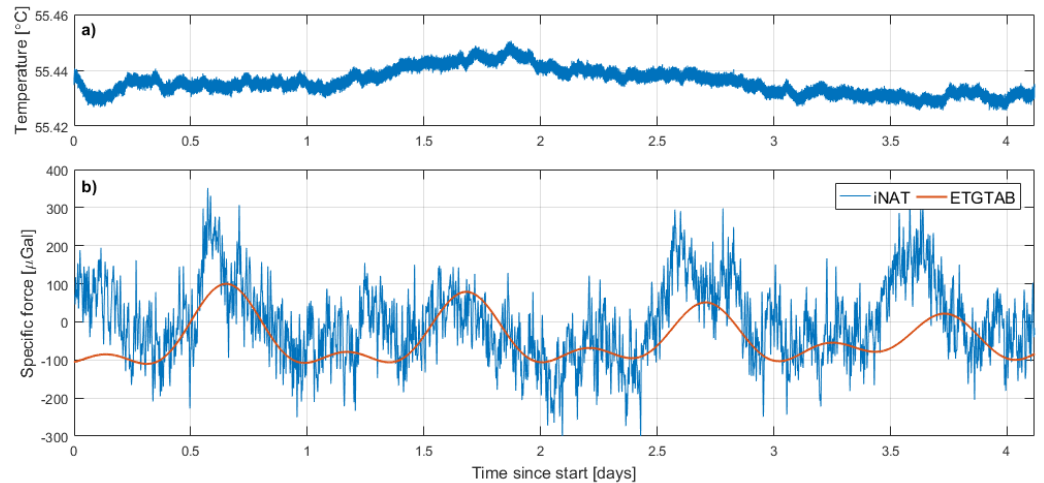
Figure 1. Observations from the four-day static recording: ( a ) Temperature log. ( b ) Accelerometer measurements filtered with a time constant of 300 s and corrected for a linear trend of − 869 µ Gal/day. Also shown are the modelled solid Earth tides using the ETGTAB software [22]. The correlation coefficient between the two time series is